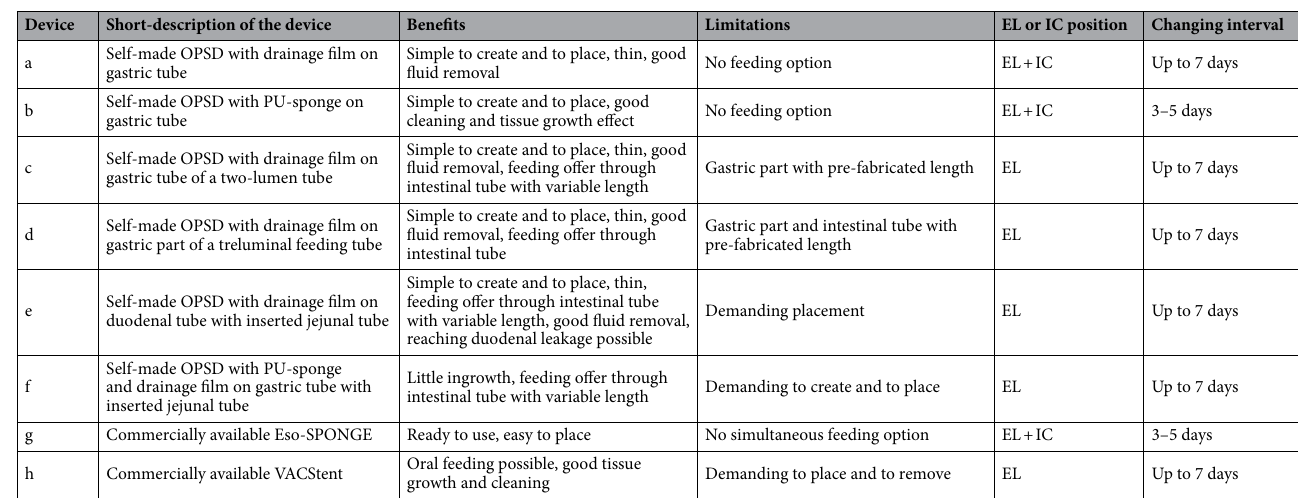
Table 2. Characteristics and clinical features of the different analysed OPSDs. PU = polyurethane, EL = endoluminal, IC =